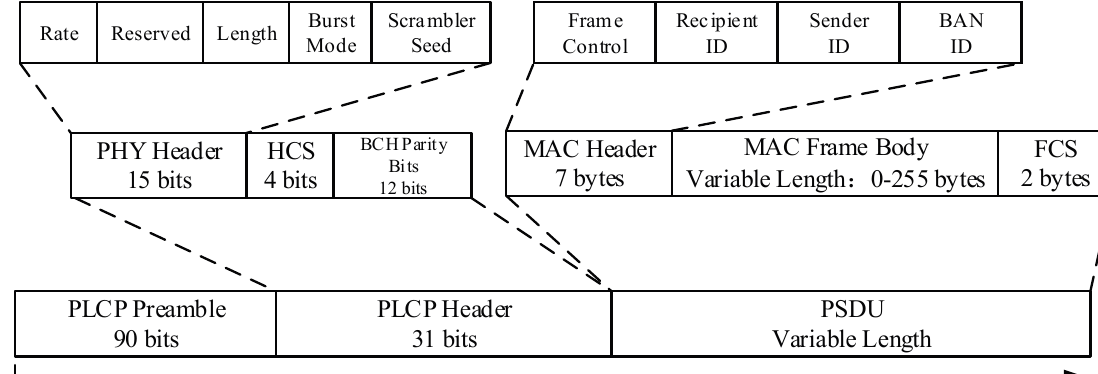
Figure 3. Physical layer protocol data unit structure of IEEE